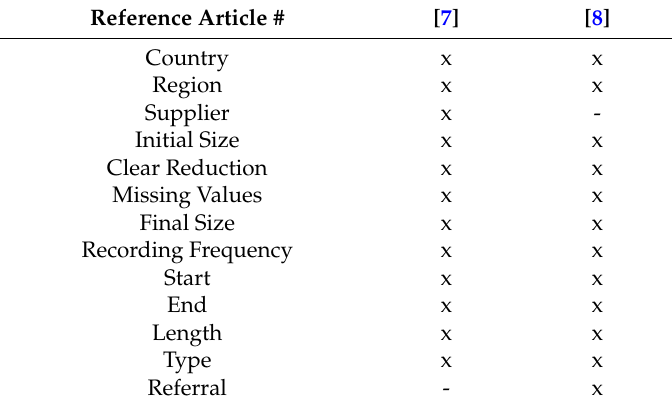
Table 3. Example of the Data Description Score result on 2 articles, paper 7 has no referral and scores 12, while paper 8 has referral but no Provider information and equally scores